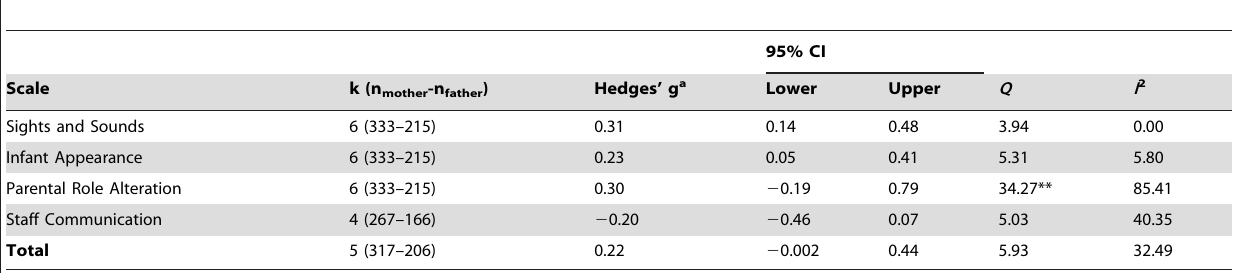
Table 7. Meta-Analytic Results of Standardized Differences in PSS:NICU Scores Between Mothers and Fathers of Preterm-Born